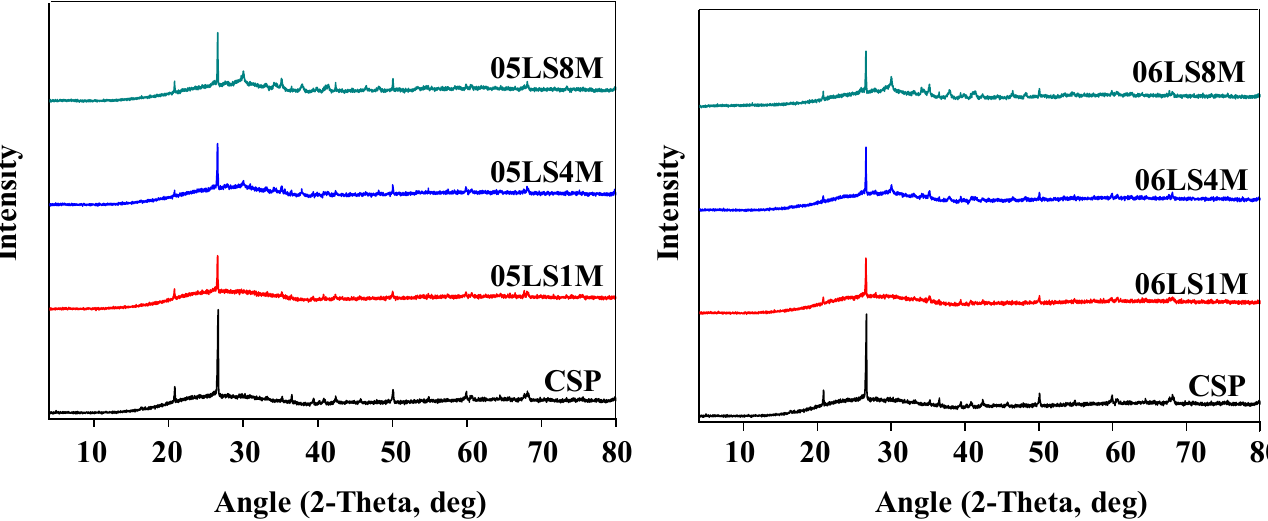
Figure 4. X-ray diffraction (XRD) results for the CSP precursor and the different AAC formulations obtained depending on the liquid-to-solid ratio (L/S) ratios (0.5 and 0.6) and the NaOH concentration.